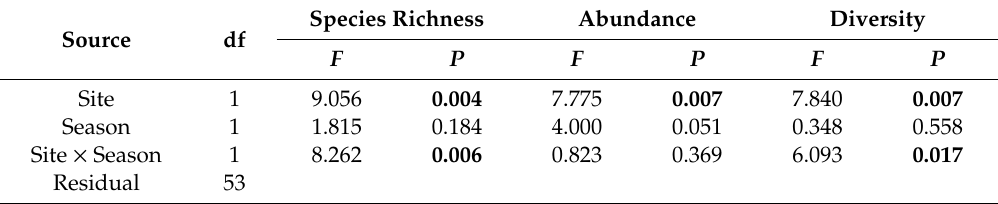
Table 2. Results of two-way analysis of variance (ANOVA) on the number of species, abundance, and diversity of fish assemblages in the lower Nakdong River, South Korea; bold face indicates statistical significance at P < 0.05.